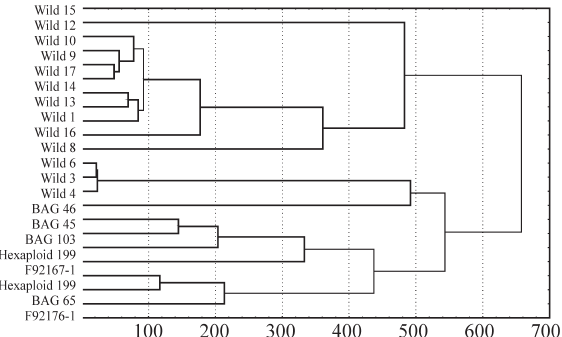
Figure 8 - Dendrogram obtained by the closest neighboring method, from the Mahalanobis distance, for 21 accessions of Pennisetum spp. of the Germplasm Bank of Embrapa Gado de Leite. UFLA. Lavras, MG, Brazil,